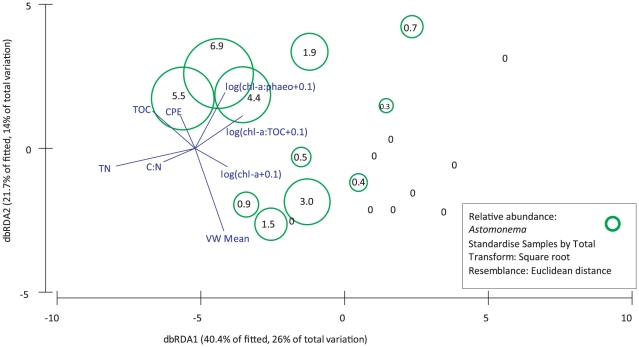
Distance-based redundancy (dbRDA) bubble plot illustrating the DISTLM model based on the genera assemblage data and fitted environmental variables with their vector (strength and direction of effect of the variable on the ordination plot).Axis legends include % of variation explained by the fitted model and % of total variation explained by the axis. Relative abundance of the ‘chemosynthetic’ Astomonema nematodes is visualised by the size of the circles, including the value of their relative abundance in each sample. Chl-a: chlorophyll a, CPE: chloroplastic pigment equivalents, Chl-a∶phaeo: chlorophyll a divided by its degradation products (phaeophytines) indicating ‘freshness’ of the phytodetrital OM, TN: total nitrogen content, TOC: total organic carbon content, C∶N: molar carbon-nitrogen ratio, Chl-a∶TOC: chlorophyll a divided by total organic carbon content indicating bioavailability of the bulk OM, CPE∶TOC: total pigment derived matter relative to the bulk OM, VW Mean: volume weighted mean grain size.